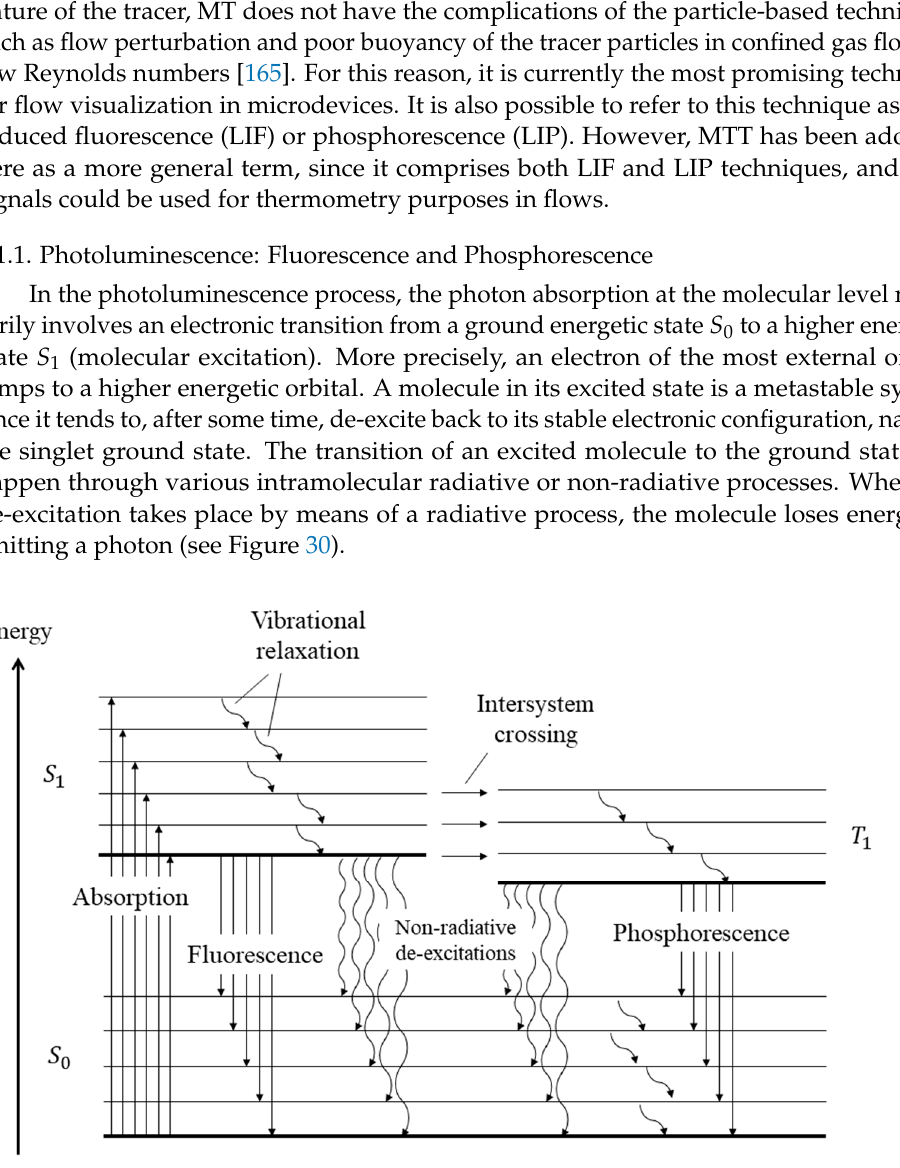
Figure 30. Jablonski energy-level diagram. The straight lines represent radiative processes, the wavy lines represent non-radiative processes. The non-radiative de-excitations include both internal and external conversions [ 166 ] . Reproduced with permission of the author.